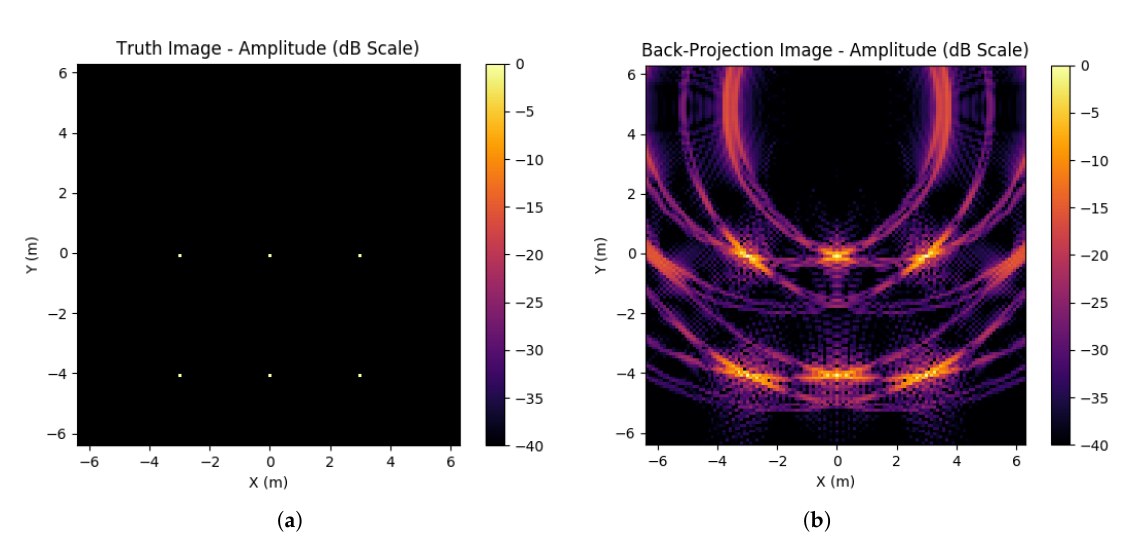
Figure 2. Ground truth and corresponding back-projection image. This back-projection image is formed from the absolute value of the complex image data. ( a ) Ground truth of 6 scatterers of RCS 1; ( b ) Back-projection image ( A T Φ ) from an aperture of 10% data